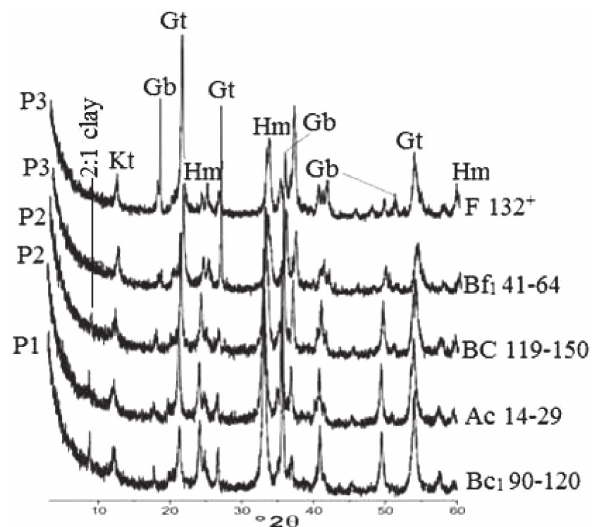
Figure 5. X-ray diffractogram of petroplinthites of the Bc 1 horizon, the Ac and BC horizons, and Bf 1 and F layers of the well-drained P1, P2 and P3 profiles, respectively: Kt, Kaolinite; Gb, Gibbsite; Hm, Hematite; Gt, Goethite; and 2:1 clay